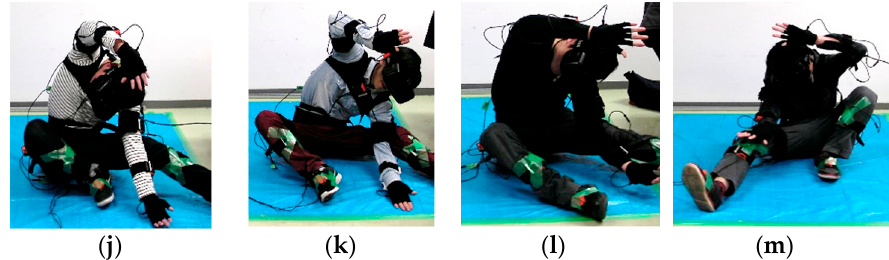
Figure 7. A presented pose and its reproduced poses: ( a ) Presented; ( b – l ) successfully reproduced; ( m ) left and right reversed.